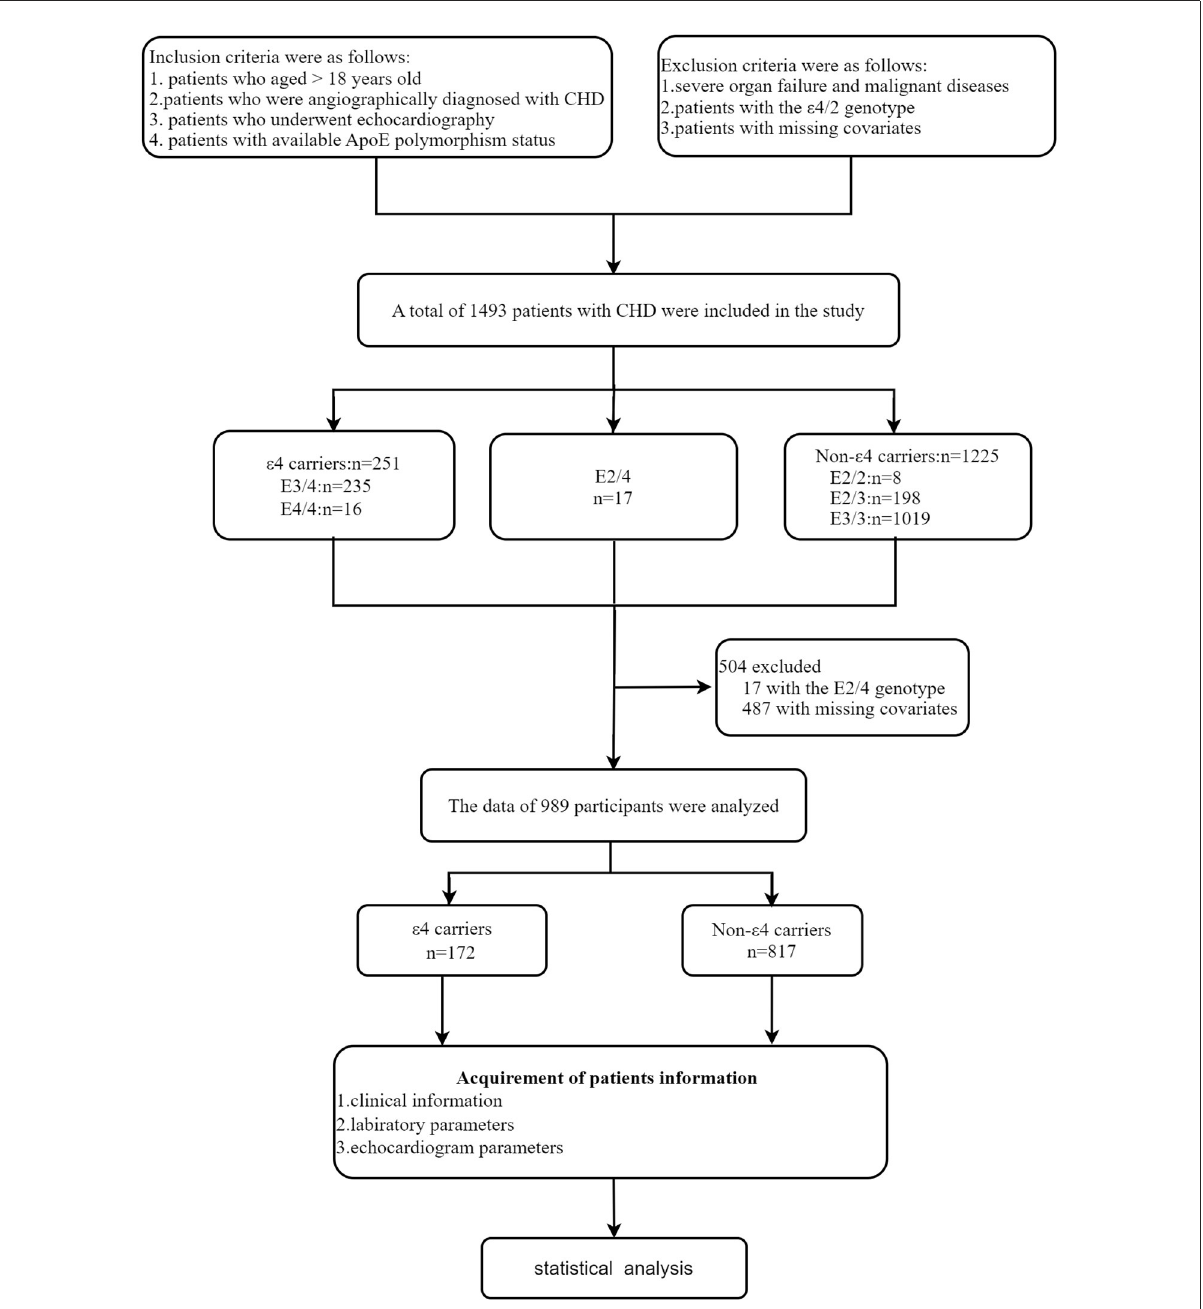
FIGURE1 Study design of the present work.